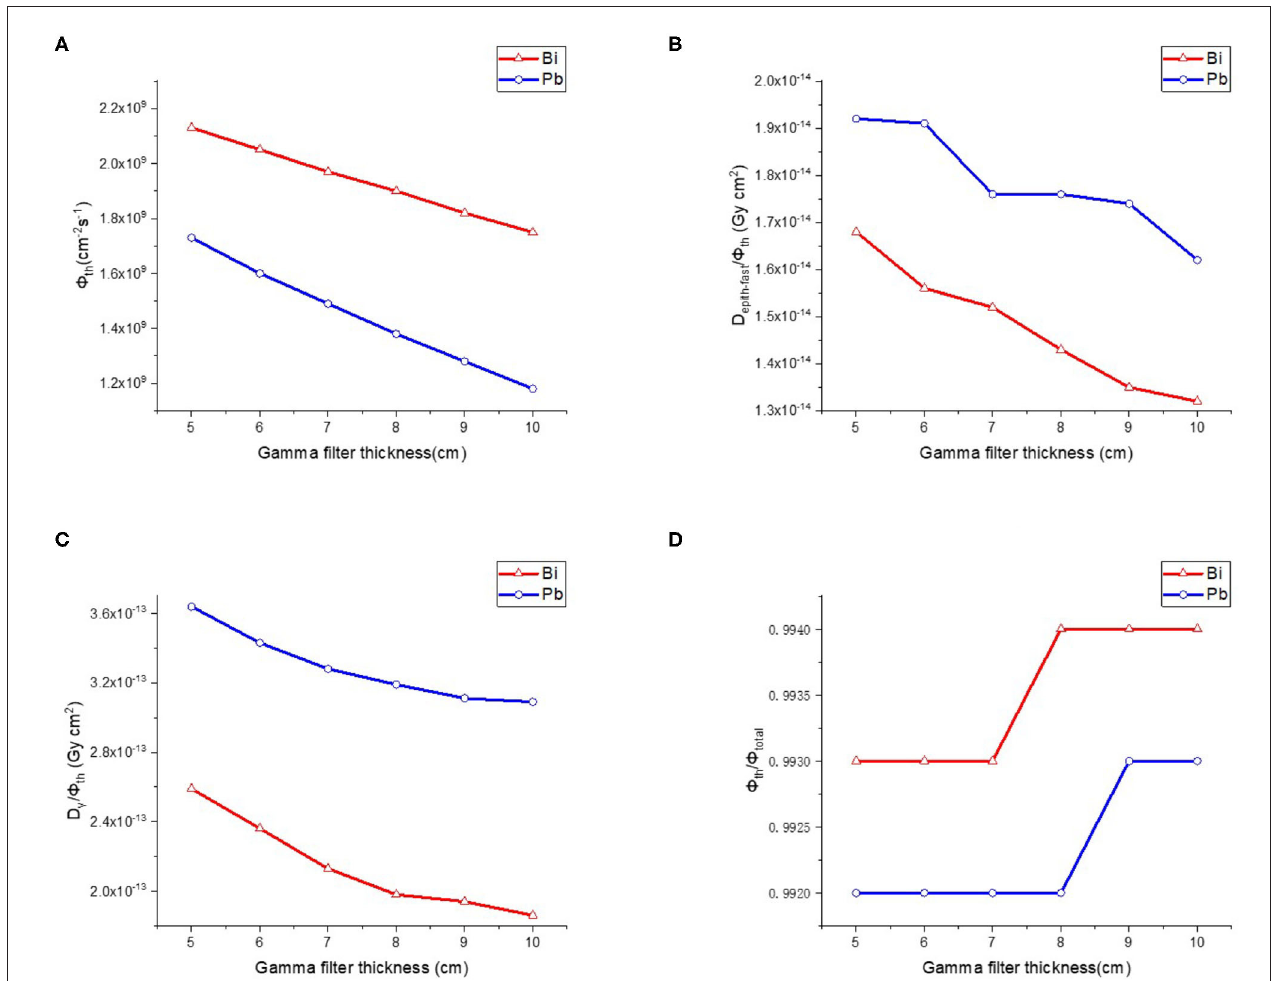
FIGURE 6 | Thermal neutron parameters of gamma filter, (A–D) are thermal neutron flux, thermal neutron ratio, epithermal, and fast neutron component, Gamma component,